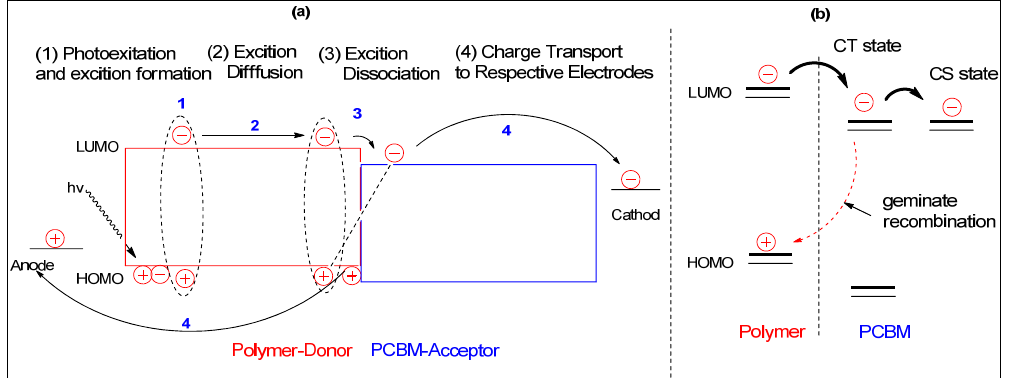
Figure 12. ( a ) Schematic diagram demonstrating the operating mechanism of a donor–acceptor BHJ device. ( b ) Basic energy level diagram for the photovoltaic process. device. ( b ) Basic energy level diagram for the photovoltaic